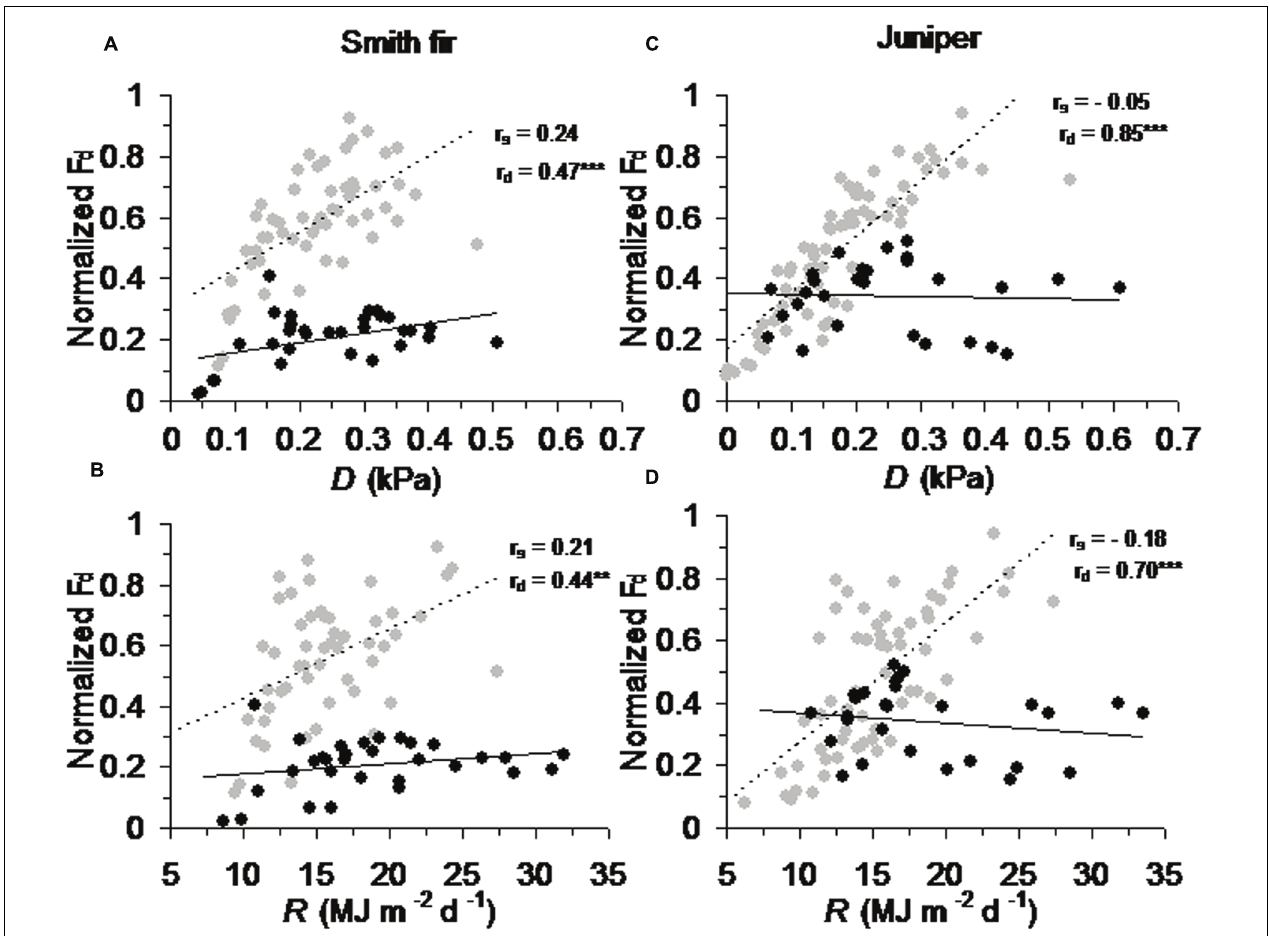
FIGURE 6 | Correlations between normalized daily sum sap flow density (normalized F d ) across pre- and post-summer solstice growing seasons of Smith fir trees and meteorological factors of (A) vapor pressure deficit ( D ) and (B) solar radiation ( R ), and of juniper trees and meteorological factors of (C) D and (D) R . The solid trend line ( r s ) is for normalized F d in pre-summer solstice (black circle), and the dashed trend line ( r d ) is for normalized F d in post-summer solstice (gray circle). ∗ P < 0.05; ∗∗ P < 0.01; ∗∗∗ P <